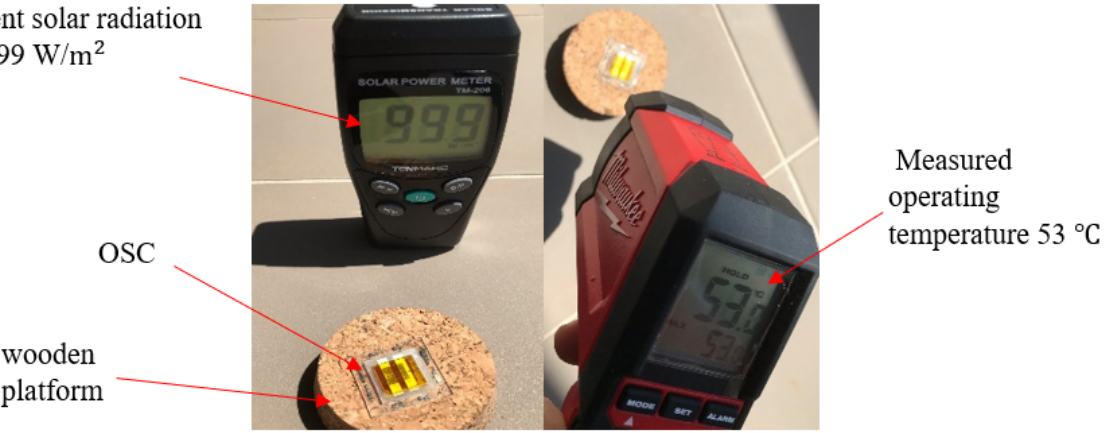
Figure 2. The measured incident solar radiation and operating temperature of the OSC in